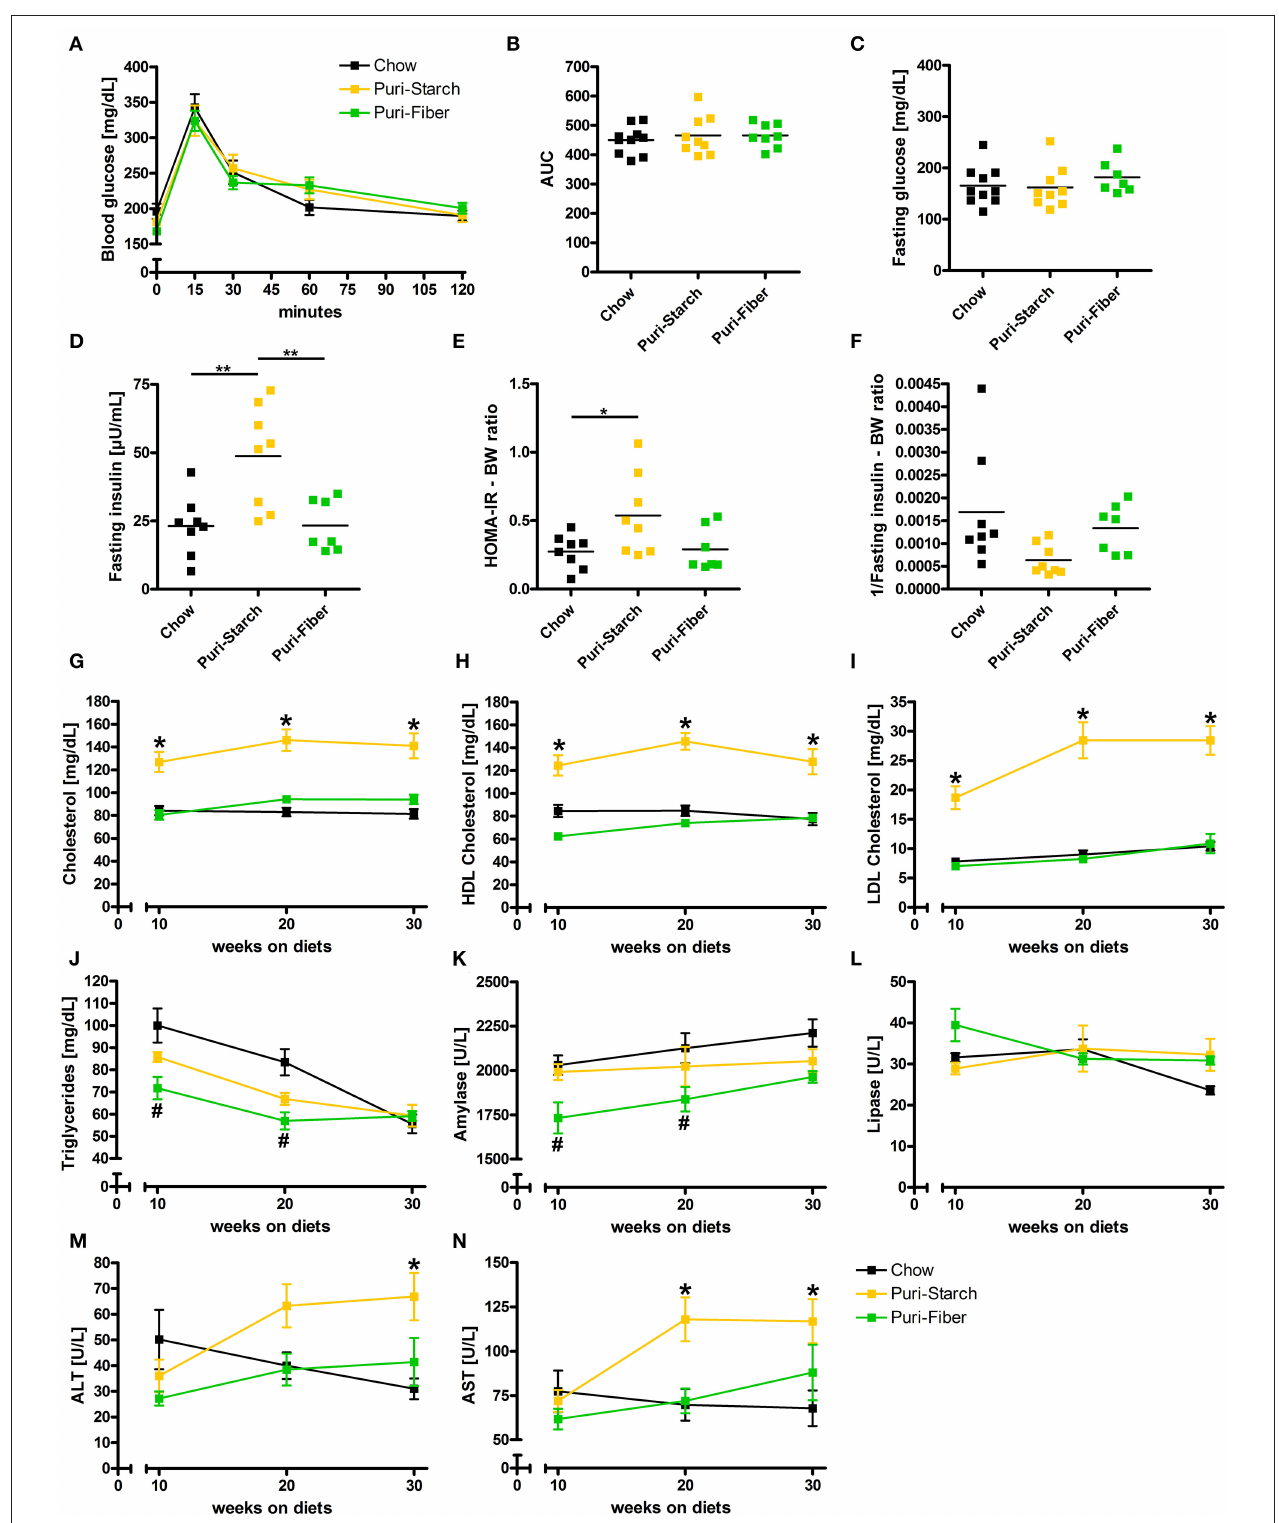
FIGURE 2 | Effects of diets on glucose homeostasis and circulating lipids and enzymes. (A) Blood glucose concentrations during the oral glucose tolerance test. (B) Area under the curve (AUC) of glucose tolerance test curves. (C) Fasting plasma glucose concentrations. (D) Fasting plasma insulin concentrations. (E) Calculated Homeostatic Model Assessment for Insulin Resistance (HOMA-IR) related to body weight. (F) Calculated 1/insulin (index for insulin sensitivity) related to body weight.